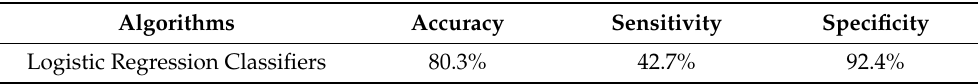
Table A1. Detailed classification performance of logistic regression classifiers.